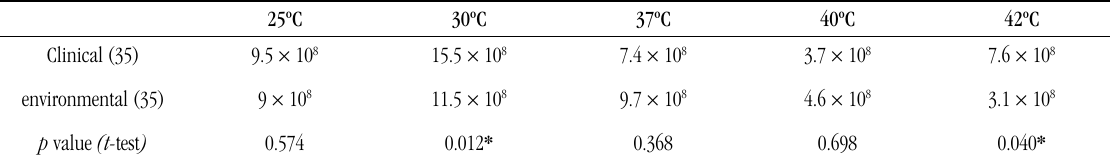
tABLE 1 – Mean microorganism concentrations in the seventh day of thermotolerance reading and correlation of tested temperatures and strain origins